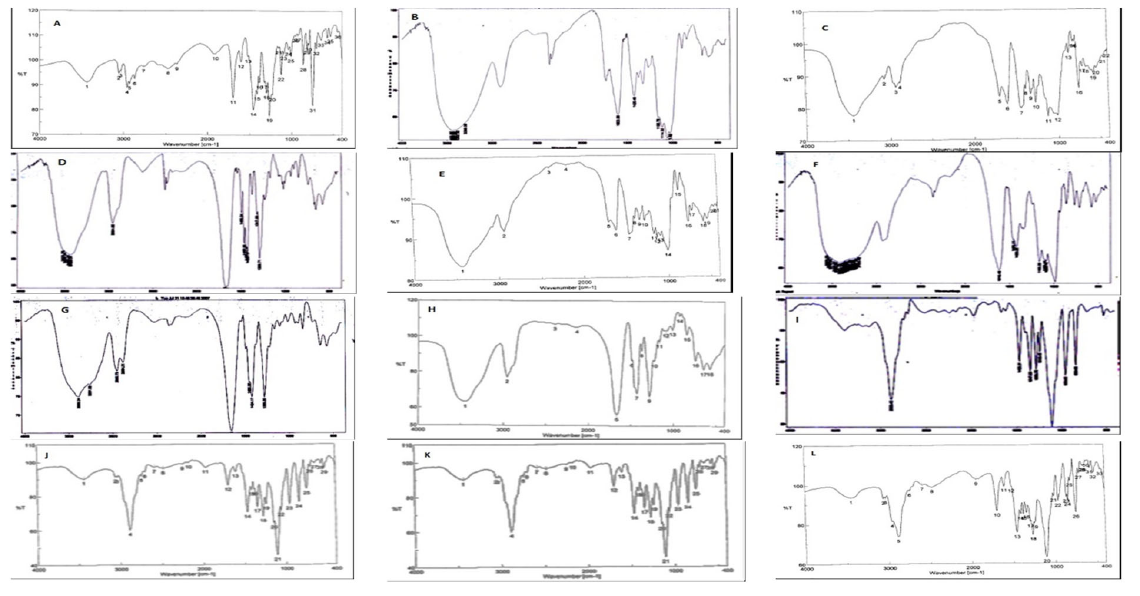
Figure 1. FT-IR of ( A ) Tel, ( B ) CCS, ( C ) physical mixture of Tel with CCS, ( D ) CP, ( E ) physical mixture of Tel with CP, ( E ) SSG, ( F ) physical mixture of Tel with SSG, ( G ) PVP k30, ( H ) physical mixture of Tel with PVP K30, ( I ) PEG 4000, ( J ) physical mixture of Tel with PEG 4000, ( K ) Poloxmer 407, ( L ) physical mixture of Tel with Poloxmer 407.